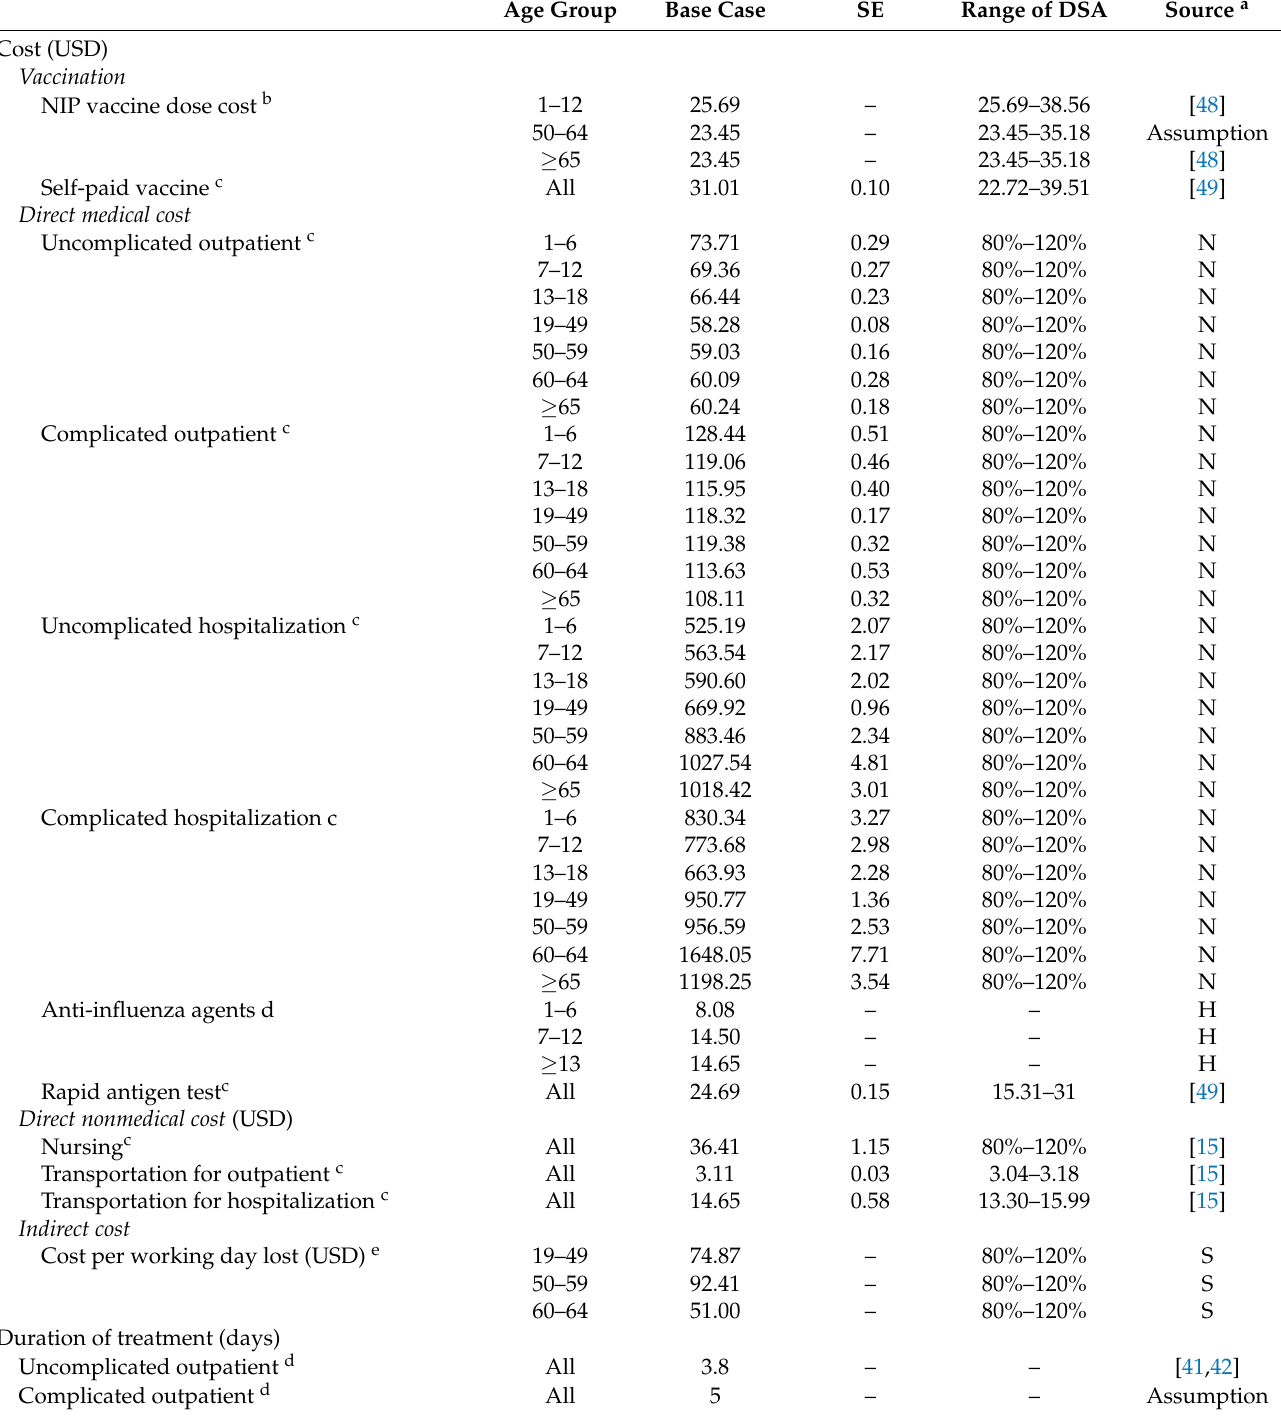
Table 3. Cost inputs by age